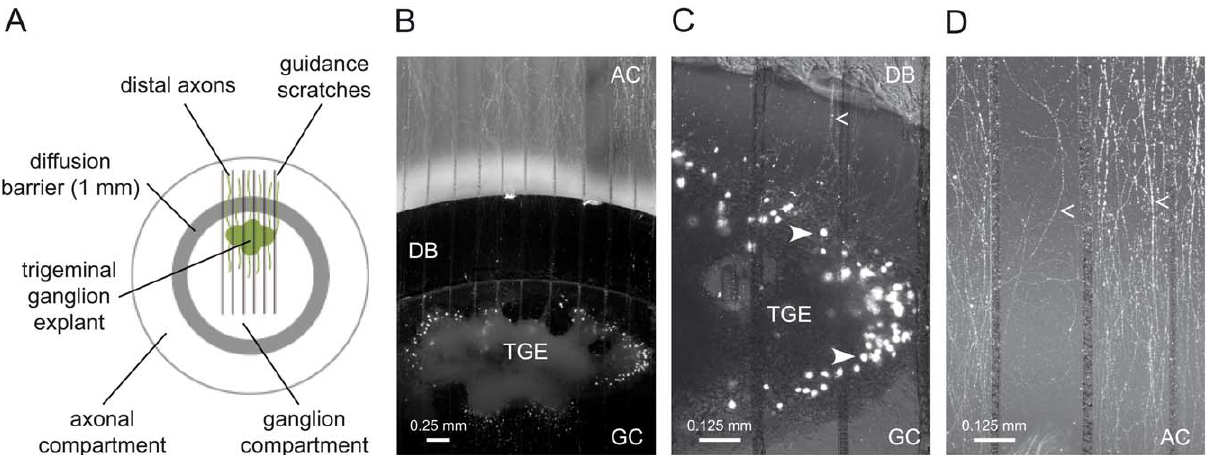
Figure 1. Trigeminal ganglion explant cultures. (A) Scheme of the double chamber system. (B–D) Trigeminal ganglion explant (TGE) cultures stained with DiI in the axonal compartment (AC) 48 h before imaging: (B) overview and (C, D) typical DiI-positive neurons (solid arrowheads) and neurites (arrowheads) in the ganglion compartment (GC) and AC shown at higher magnification. DB, diffusion barrier.